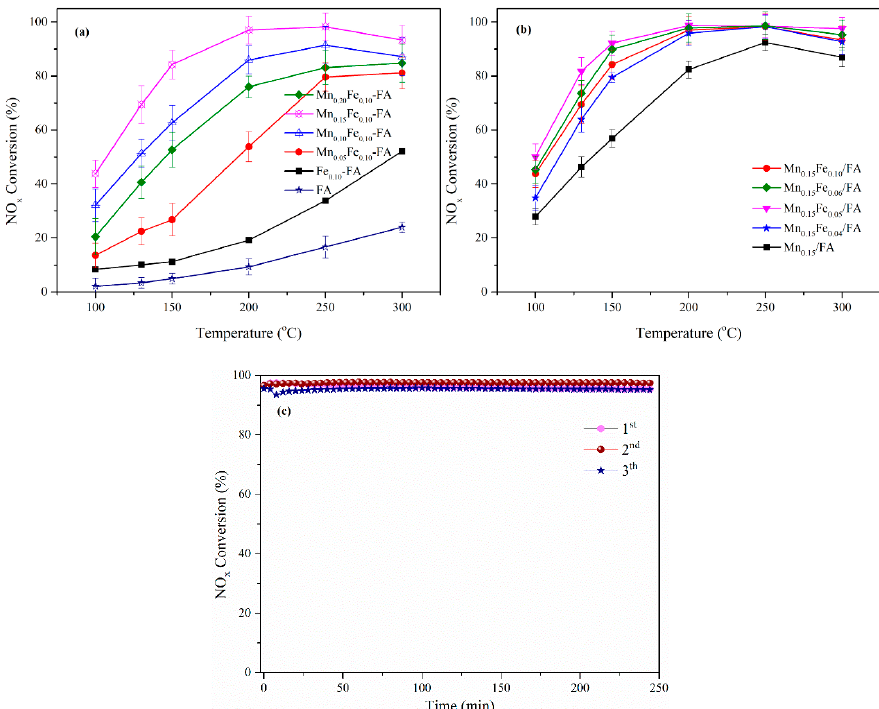
Figure 1. NO x Conversion during the NH 3 -SCR process over Mn x Fe 0.10 /FA with different Mn content (x = 0, 0.05, 0.10, 0.15, and 0.20) ( a ) and Mn 0.15 Fe y /FA with different Fe content (y = 0, 0.04, 0.05, 0.06, and 0.10) ( b ); and the stability of the Mn 0.15 Fe 0.05 /FA catalyst at 200 ° C ( c ). Experimental conditions: 1000ppm of NO, 1000pp of NH 3 , 5 vol.% O 2 and N 2 as the balance gas, GHSV of 50,000 h − 1 . Table 2. Summary of typical MnFeO x oxide catalysts used for the NH 3 -SCR process. Catalyst